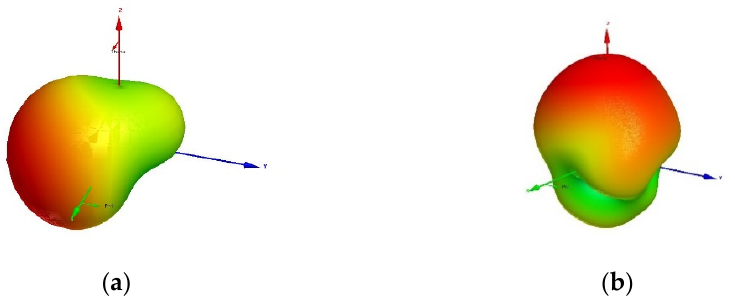
Figure 15. Realized gain at ( a ) 402.5 MHz and ( b ) 2.45 GHz. Table 2. Results of maximum Realized Antenna Gain extracted from simulations. Realized Gain (dB) Frequency